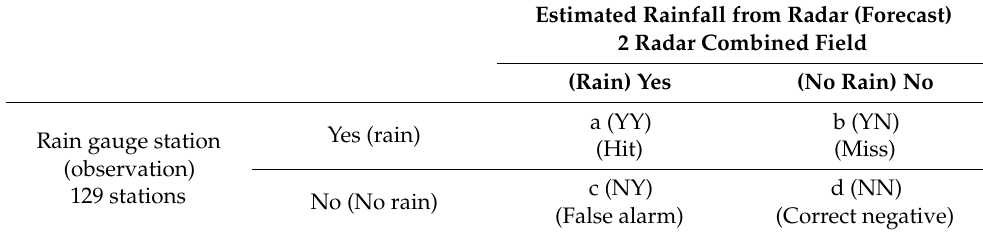
Table 1. Binary Contingency table for whether or not rain is